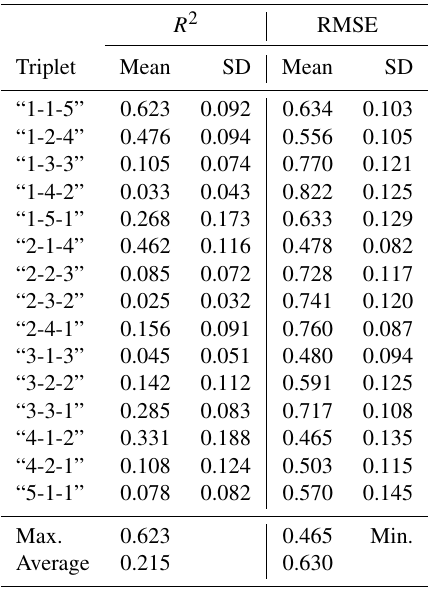
Table 5. R 2 and RMSE (ln (cmh − 1 )) values for linear regressions of IE vs. ln K sat using the 15 different triplets for the SC2